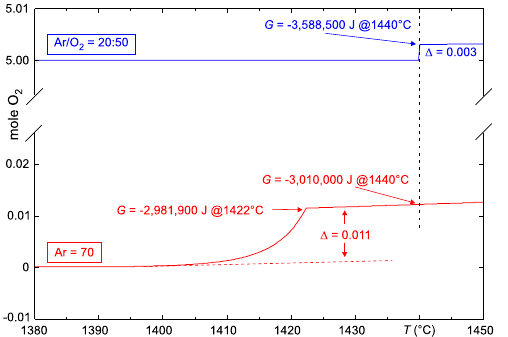
Figure 3. Calculated equilibrium of 0.7 mol CaO + 0.3mol Fe 2 O 3 in 5mol O 2 + 2mol Ar, or in 7mol Ar, respectively. The curves show the total amount of O 2 in the atmosphere. Total Gibbs energy G of the system given at selected